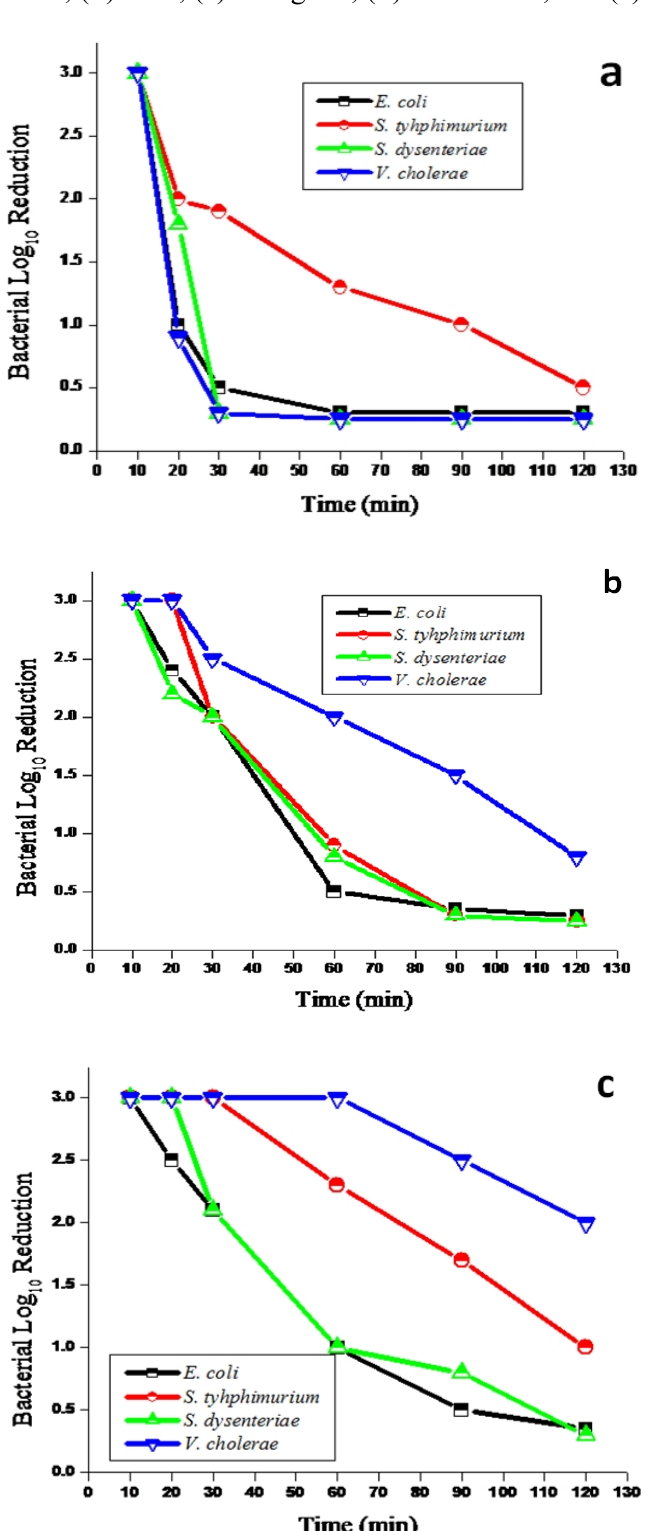
Figure 6. Antibacterial activity of various Ag nanoparticle substrates at 0.01 mM concentration against E . coli , S. typhimurium , S. dysenteriae and V. cholerae in groundwater: ( a ) zeolite, ( b ) sand, ( c ) fibreglass, ( d ) anion resin, and ( e ) cation